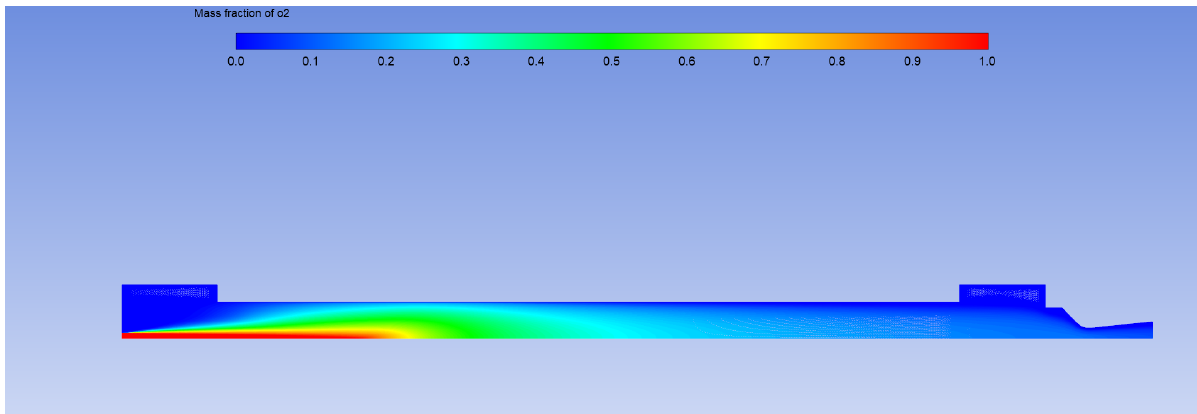
Figure 8. O 2 mass fraction field of test